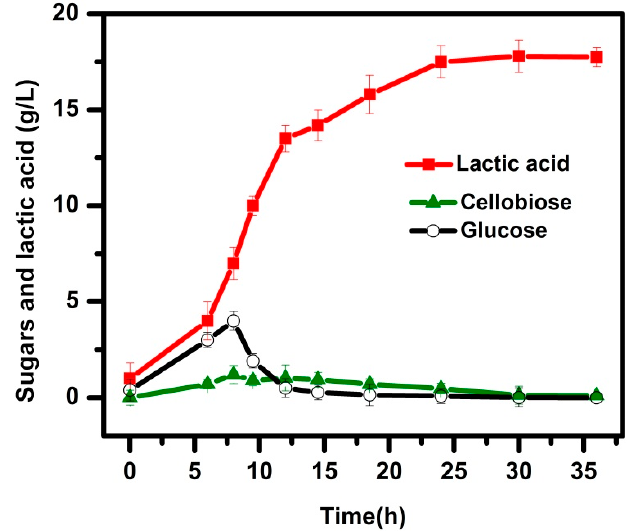
Figure 3. Time courses of SSF by B. coagulans IPE22 using mMRS as nutrient supplement. SSF was carried out at 5.3% ( w / v ) solid loading, which corresponds to 30.18 g of cellulose per 1 L liquid mMRS medium at the cellulase loading of 20 FPU/g cellulose. Symbols represent: lactic acid, filled squares; glucose, open circles; cellobiose, filled triangles.